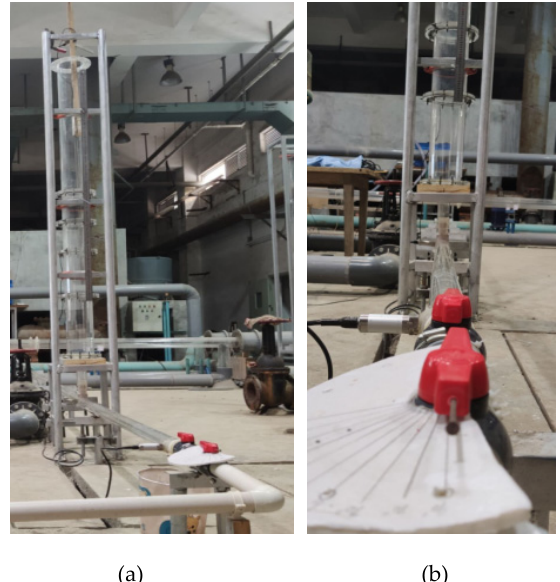
Figure 3. The experimental equipment. ( a ) is the graph of piping system and ( b ) is the graph of pressure Table 1. Parameters of the experimental pipeline.